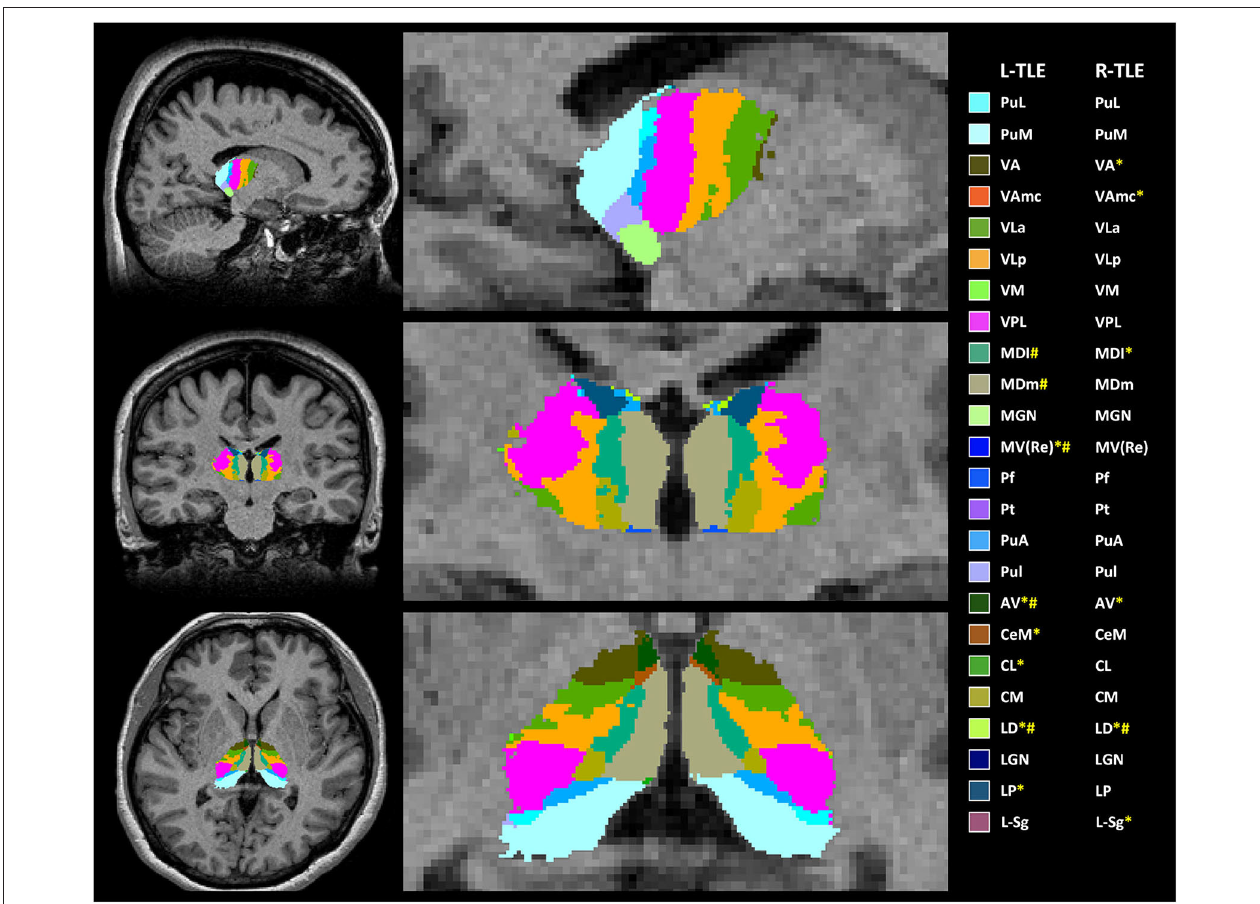
FIGURE 1 | Example of anatomical locations of the thalamic subfields generated by FreeSurfer on 3-dimensional magnetization-prepared rapid acquisition with gradient-echo (3D-MPRAGE) images in one of the patients with left-temporal lobe epilepsy (L-TLE) (not all segmentations are shown). * TLE had significantly decreased volume of thalamic subfields in the right hemisphere; # TLE had significantly decreased volume of thalamic subfields in the left hemisphere. AV, anteroventral; LD, laterodorsal; LP, lateral posterior; VA, ventral anterior; Vamc, ventral anterior magnocellular; VLa, ventral lateral anterior; VLp, ventral lateral posterior; VPL, ventral posterolateral; VM, ventromedial; CeM, central medial; CL, central lateral; Pc, paracentral; CM, centromedian; Pf, parafascicular; Pt, paratenial; MV(Re), reuniens (medial ventral); MDm, mediodorsal medial magnocellular; MDl, mediodorsal lateral parvocellular; LGN, lateral geniculate; MGN, medial Geniculate; L-Sg, limitans (suprageniculate); PuA, pulvinar anterior; PuM, pulvinar medial; PuL, pulvinar lateral; PuI, pulvinar inferior.